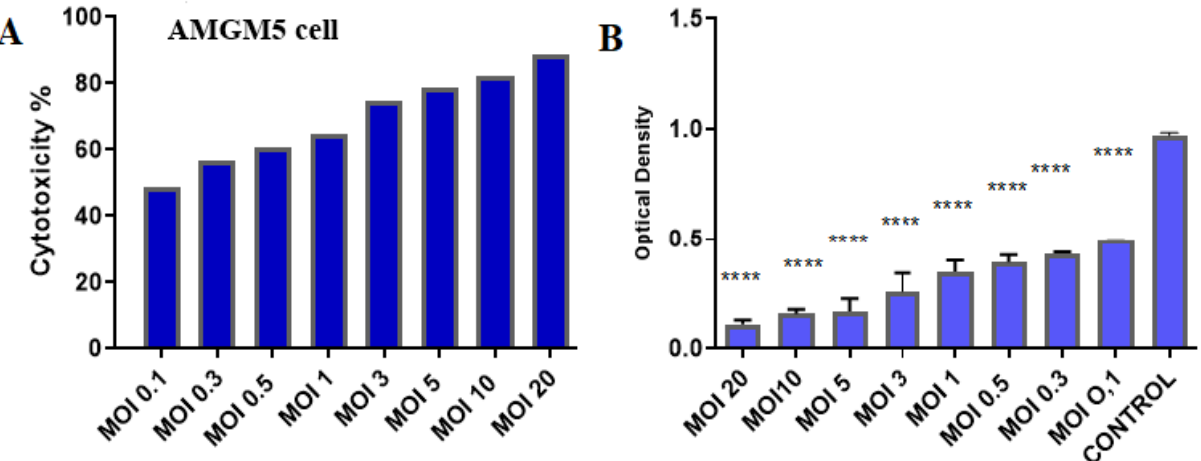
Figure 6 : (A) The cytotoxic effect, (B) Optical density of NDV on AMGM5 cell lines were studied using different MOI (0.1,0.3,0.5,1,3,5,10, and 20) for 72 hours. The MTT viability assay was used to measure the cytotoxicity of the NDV, it was shown in terms of the rate of G.I. for Cancerous cells, and all MOI demonstrated significant inhibition.